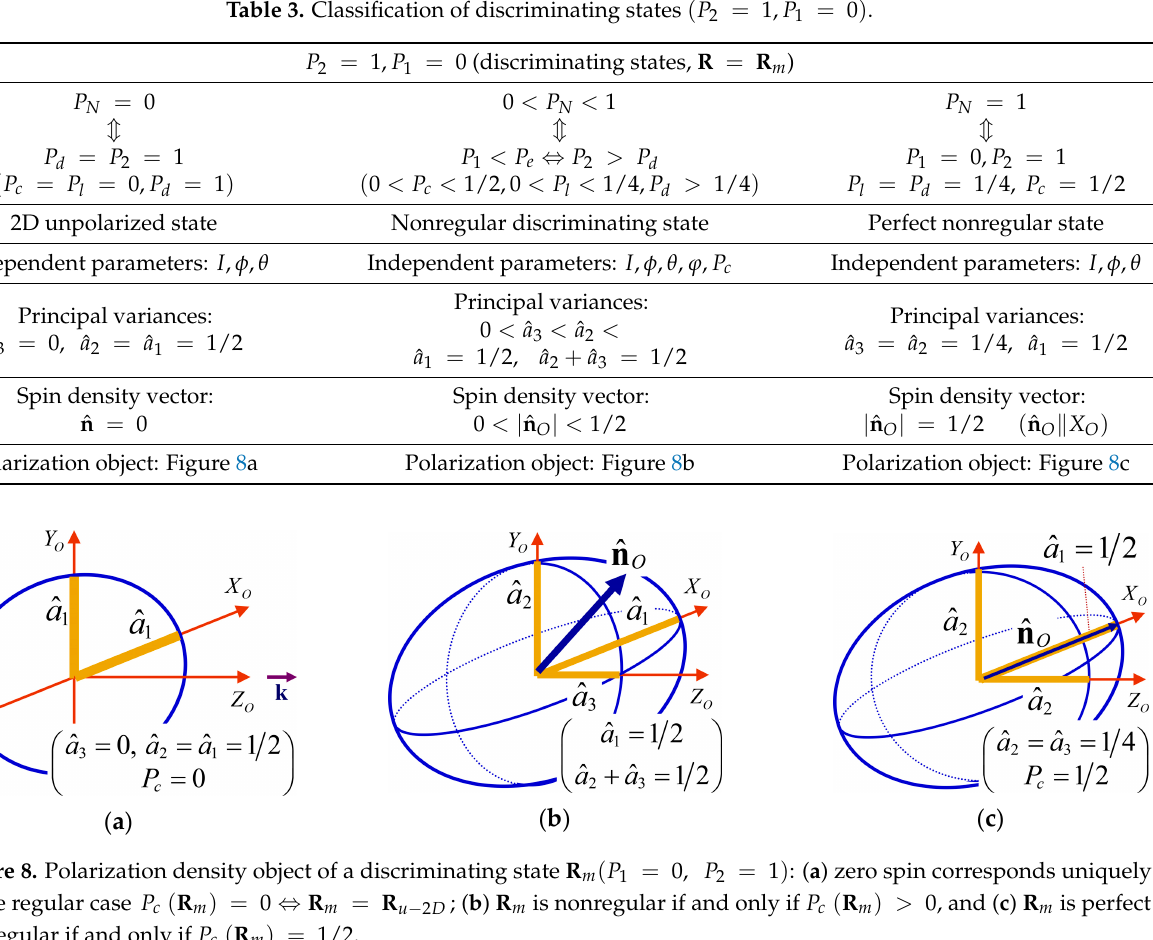
Table 3. Classification of discriminating states ( P 2 = 1, P 1 = 0 ) .